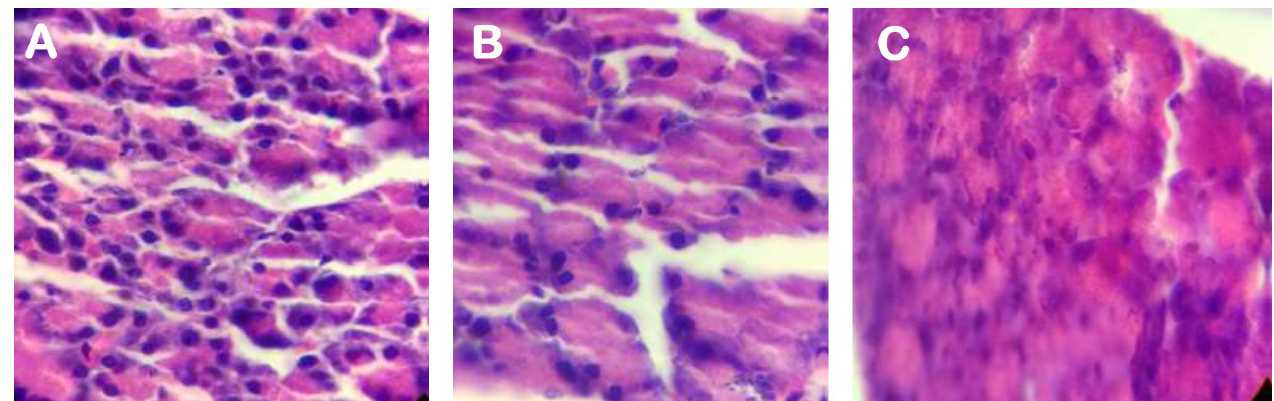
FIGURE 2 - Histopathological study of the pancreas, before and during the induction of diabetes (A and B) and at the end of the treatment with CDGO (C).